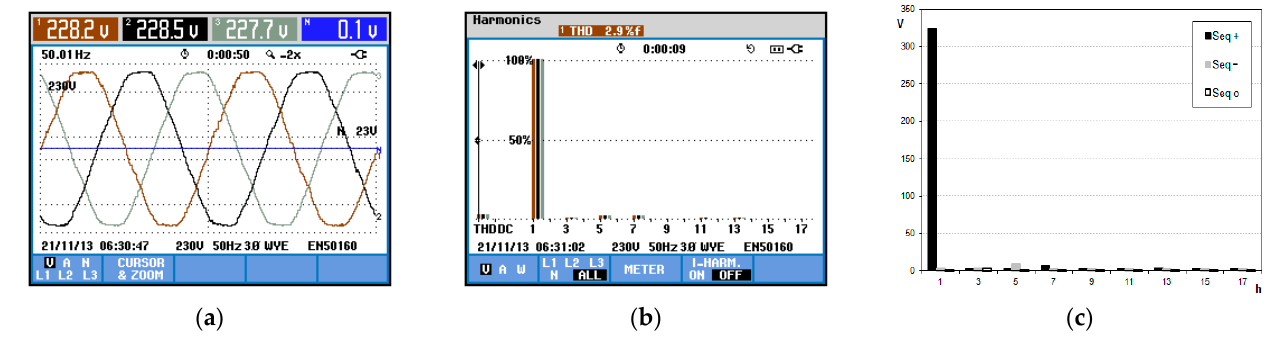
Figure 33. Case 3 - Four-wire ShAPF operating with balanced loads: ( a ) three-phase voltages; ( b ) harmonic spectrum of the voltages; ( c ) harmonic spectrum of the voltage sequence components (maximum values).